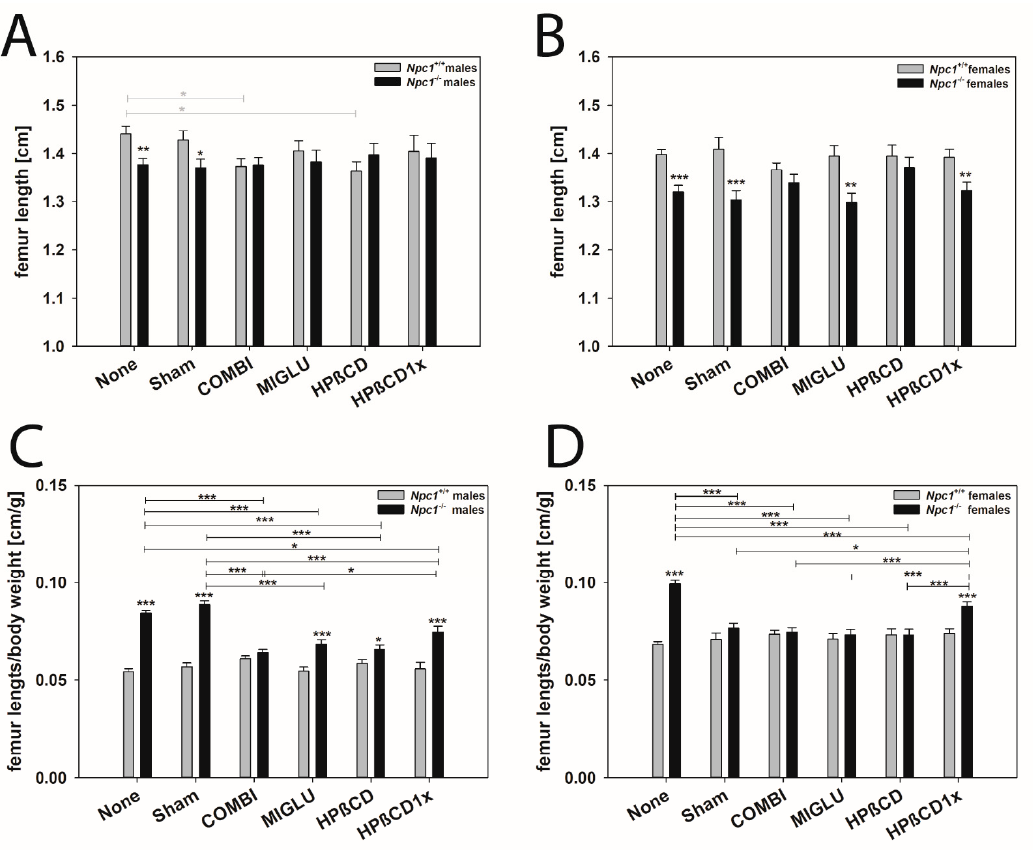
Figure 14. Femur length ( A , B ) and relative femur length ( C , D ) of Npc1 mice. Male ( A , C ) and female ( B , D ) mice. Significant post-hoc tests are indicated by asterisks (* p < 0.05, ** p < 0.01, *** p < 0.001). Data are means ± SEM.